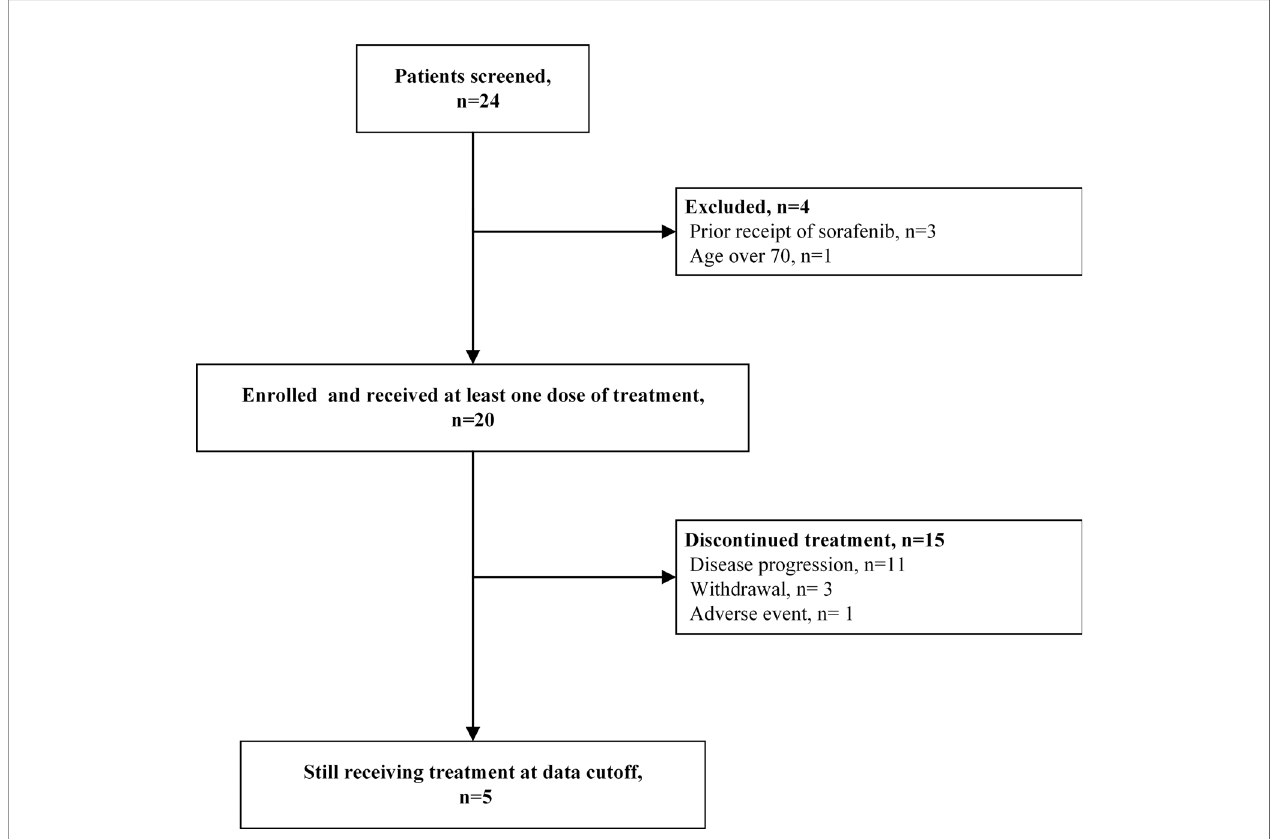
FIGURE 1 | The study fl